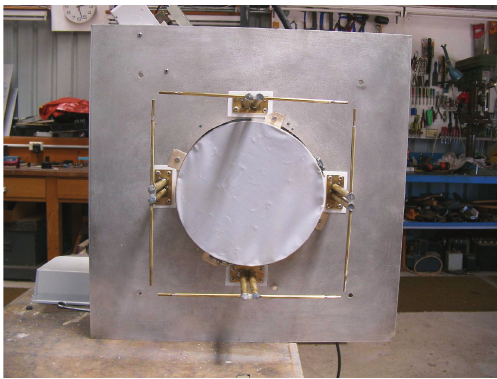
Figure 2: Front view of Doug McArthur’s feed.